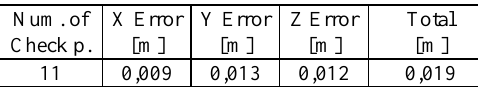
Table 3. Check points – RMSE values.